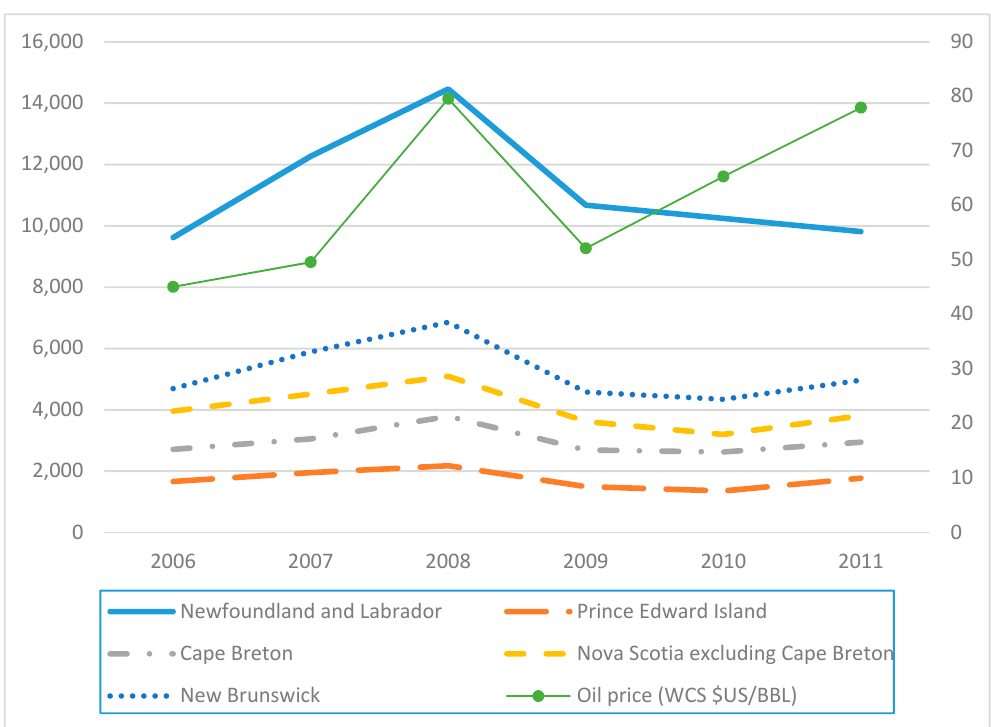
Figure 3. Number of inter-provincial employees in Alberta by province of residence, 2006 to 2011.